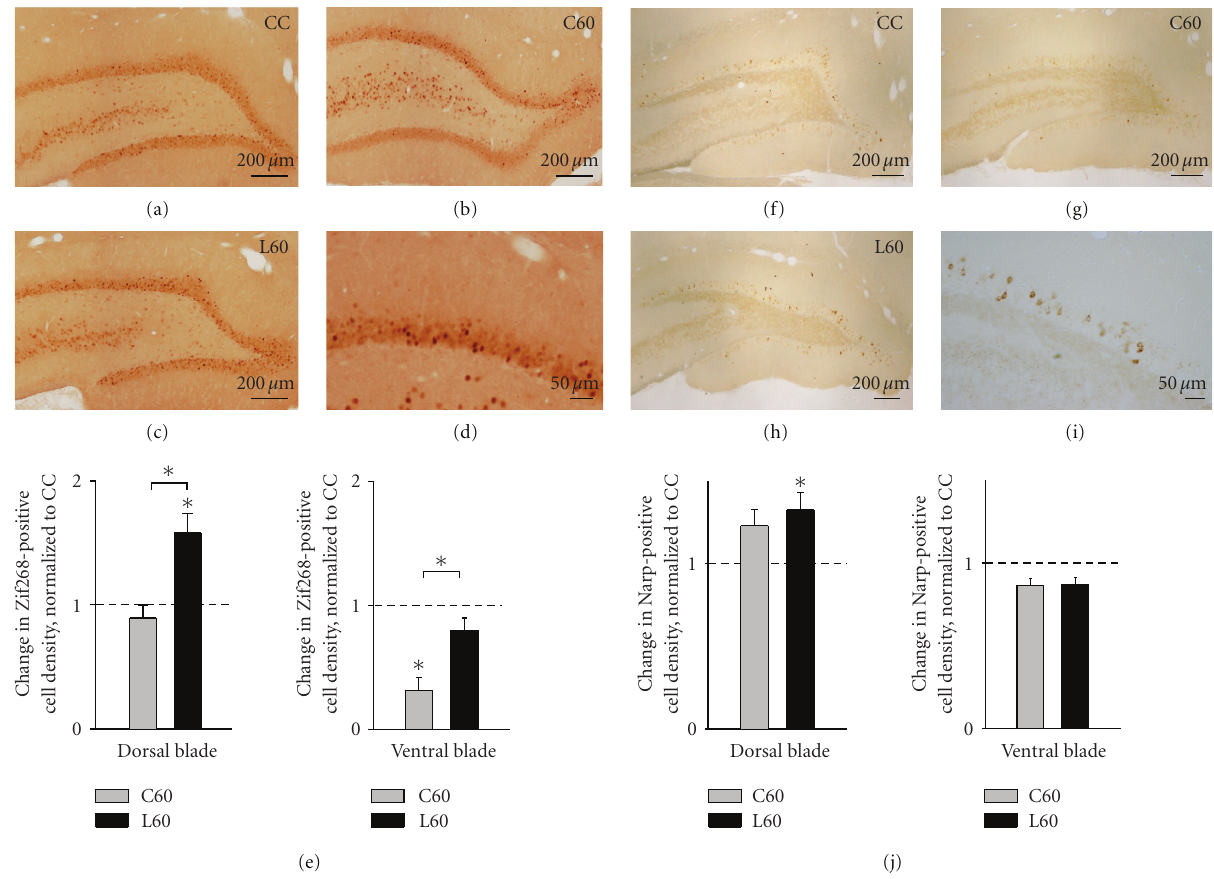
Figure 4: Object recognition training induces Zif268 and Narp protein expression in the dentate gyrus. Zif268 immunohistochemistry reveals the presence of Zif268 protein in granule cells in both blades of the dentate gyrus of (a) CC, (b) C60, and (c) L60 animals. (d) Higher magnification shows the presence of Zif268 in the nucleus of granule cells. (e) Change in density of Zif268-positive nuclei (relative to the CC group) in the dorsal and the ventral blade of the dentate gyrus across the C60 and L60 groups. Narp immunohistochemistry reveals the presence of Narp protein in granule cells in both blades of the dentate gyrus of (f) CC, (g) C60, and (h) L60 animals. (i) Higher magnification shows the presence of Narp in the cell body of granule cells. (j) Change in density of Narp-positive cells (relative to the CC group) in the dorsal and the ventral blade of the dentate gyrus across the C60 and L60 groups. Data are presented as mean ± SEM ( n = 4 for all groups). Asterisks indicate P ≤ . 05 (if not indicated otherwise, relative to CC group). Scale bars represent 200 μ m in (a)–(c) and (f)-(h) and 50 μ m in (d) and